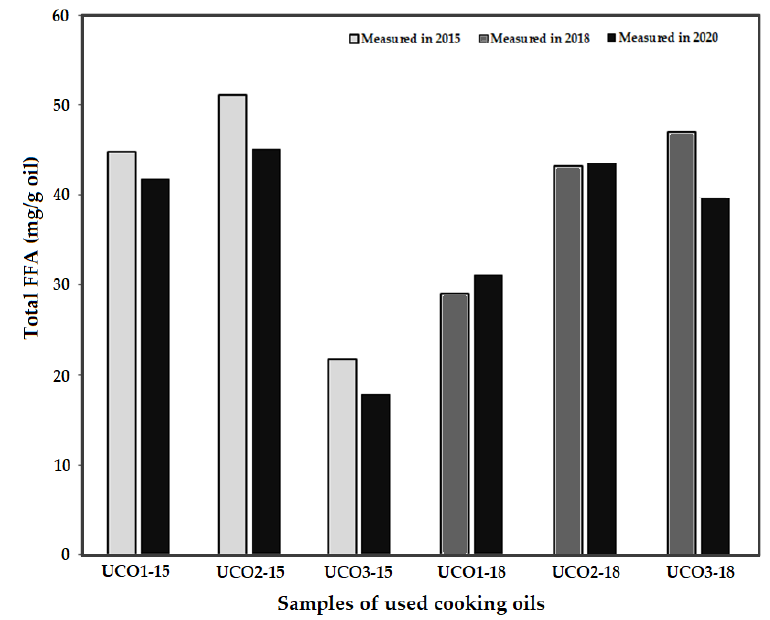
Figure 2. Change in total free fatty acids (FFAs) of different UCOs measured as received and after two and five years’ storage.